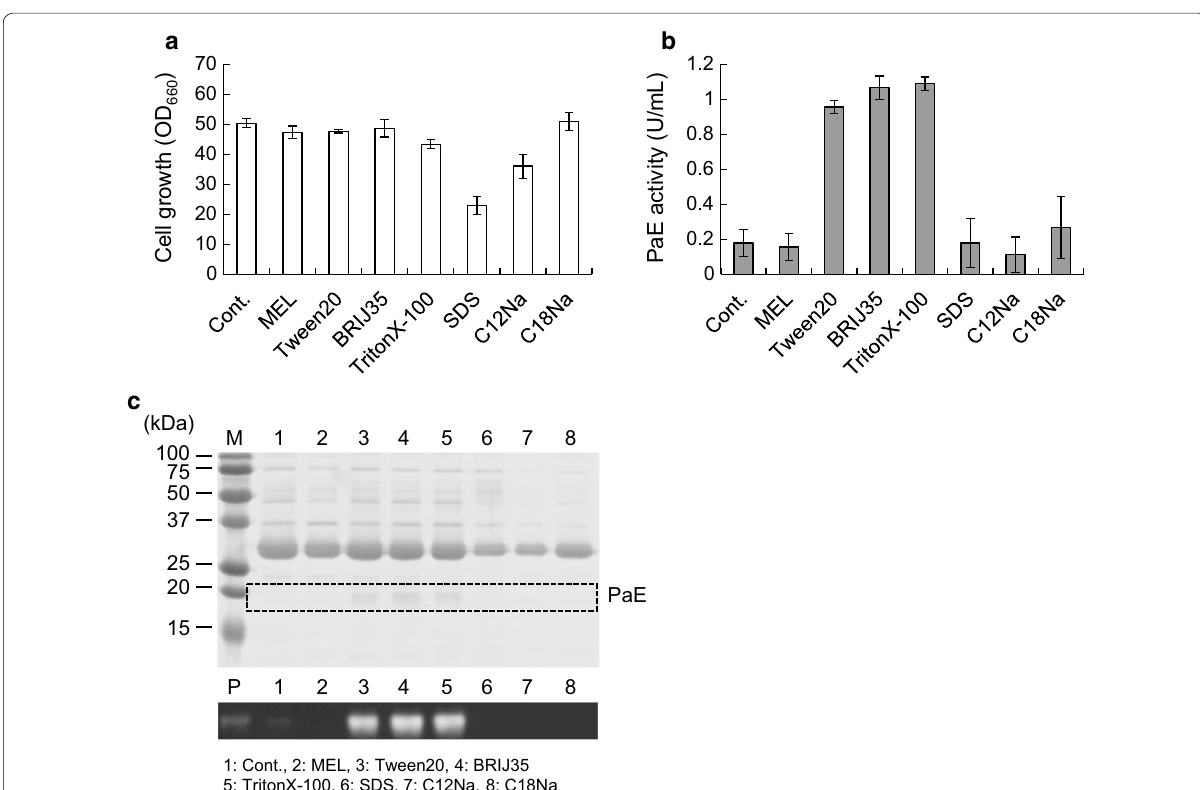
Fig. 4 PaE production by strain ∆Pa EMT1 in m -3 FMM medium supplemented with 8% xylose and 0.01% surfactants. a Cell growth. b PaE activity. × c SDS-PAGE and PaE western blot analysis of culture supernatant. M, marker; P, purified PaE; Lane 1, control; Lane 2, MEL; Lane 3, Tween20; Lane 4, BRIJ35; Lane 5, TritonX-100; Lane 6, SDS; Lane 7, sodium dodecanoate (C12Na); Lane 8, sodium octadecenoate (C18Na). The amount of each culture supernatant loaded in the gel was 10 μL for CBB staining and western blotting. The results of the cell growth and PaE activity assays are shown as the average of three different experiments. Error bars show standard deviations